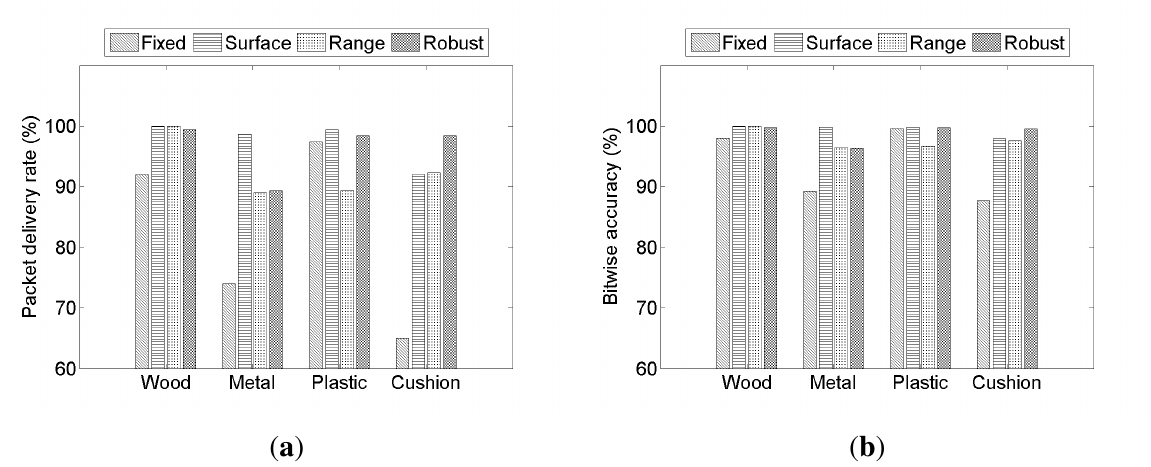
Figure 14. Comparison of different thresholding methods from Section 4.6: Fixed (a fixed threshold of α = 0 . 005 ); Surface (thresholding using surface detection); Range (thresholding using the range of standard deviations); and Robust (robust likelihood ratio test). ( a ) Packet delivery rate; ( b ) bitwise